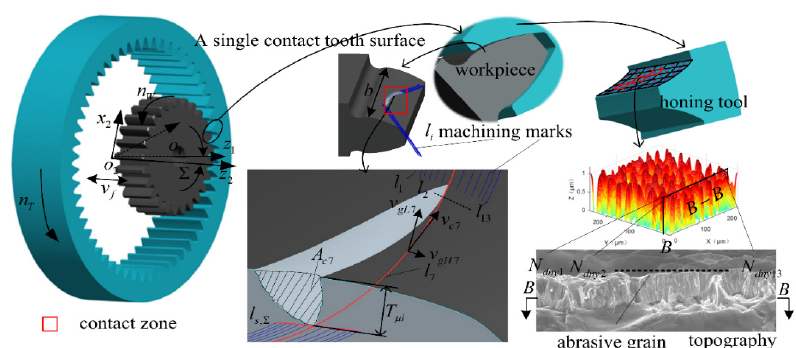
Figure 1. Honing mechanism of multi-abrasive micro-edge honing.